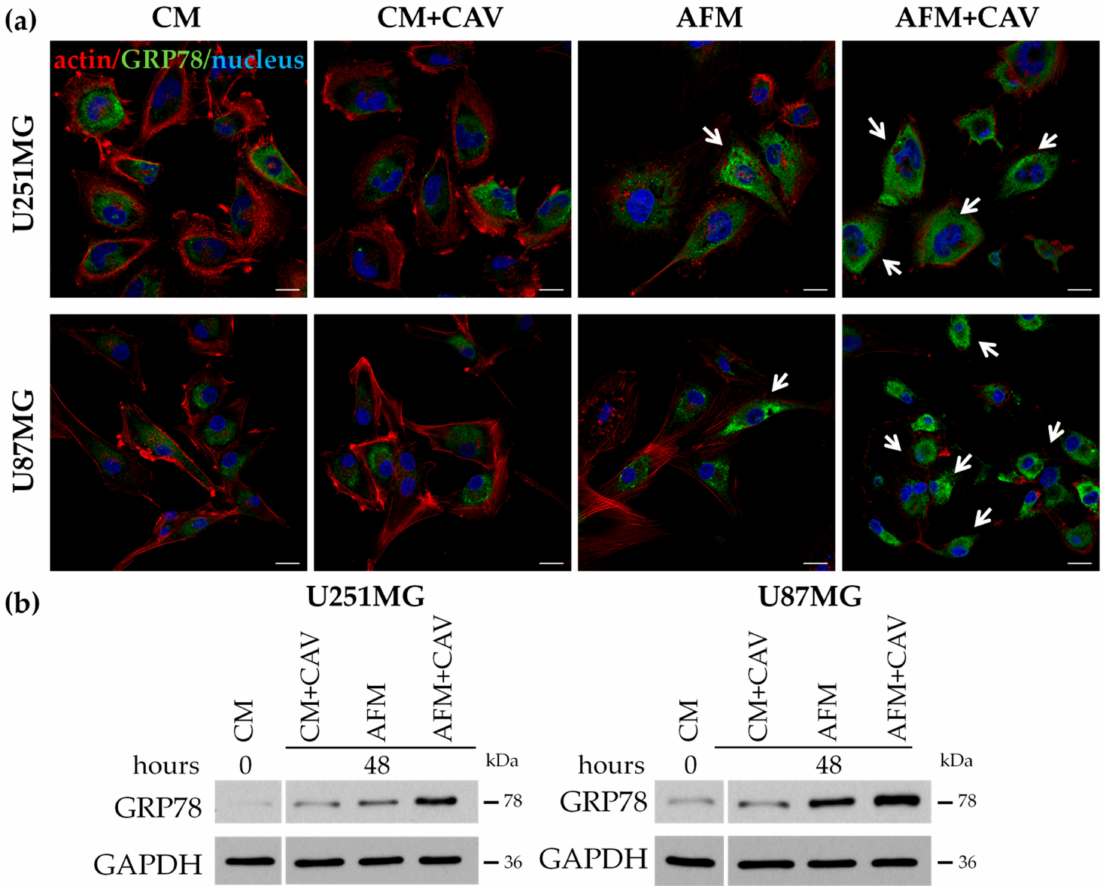
Figure 9. Canavanine (50 µ M) enhances endoplasmic reticulum (ER) stress during arginine deprivation in U251MG and U87MG human glioblastoma cells. ( a ) Immunostaining for GRP78 and actin filaments of the cells subjected to 48 h of canavanine co-treatment under arginine starvation. Nuclei were stained with DAPI. Bars, 20 µ m. Arrows point to cells with increased GRP78 fluorescence. ( b ) Western blot analysis of GRP78 protein level. GAPDH was used as a protein loading